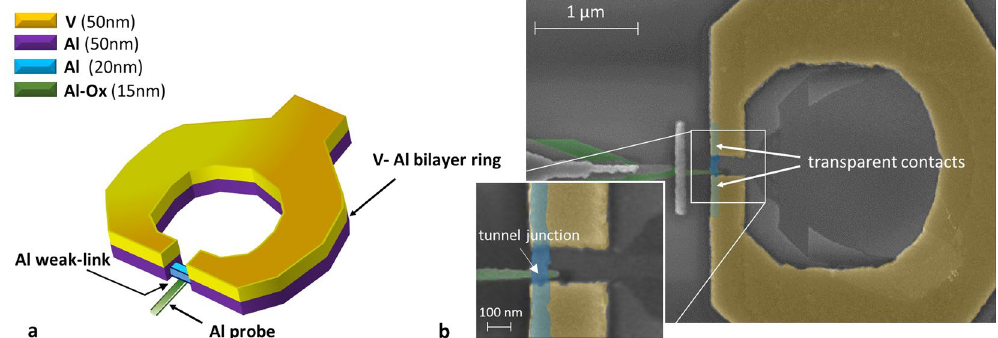
Figure 1. Design and scanning electron micrograph (SEM) of the V-based SQUIPT. ( a ) Sketch of the V-based SQUIPT. An Al nanowire is embedded into a V-Al ring and an Al probe is tunnel-coupled to the middle of the wire. ( b ) False-color SEM of sample-A with an enlarged view centered on the junction region. In the SEM image the passive metal replicas deriving from the three-angle shadow-mask evaporation are also